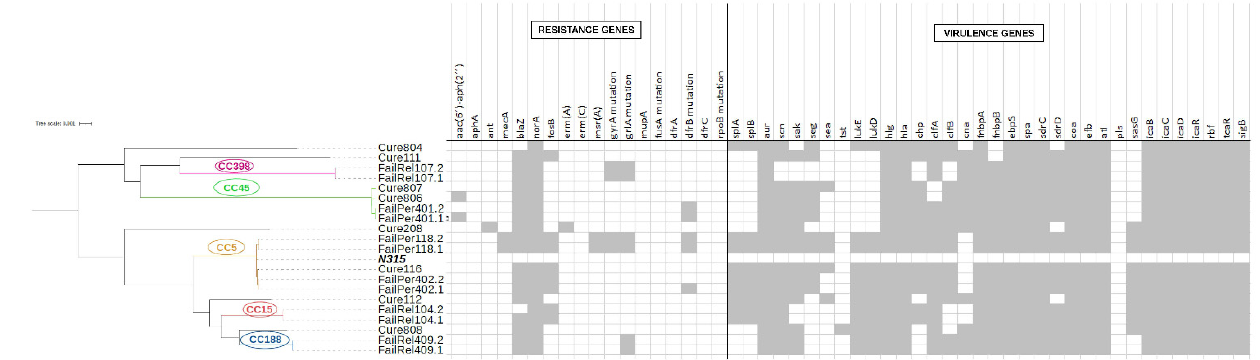
Figure 2. Phylogenetic tree of all the strains causing persistent, relapsing and resolved prosthetic joint infections included in this study, along with the main resistance and virulence genes. Grey boxes indicate the presence of that gene and the white ones its absence.